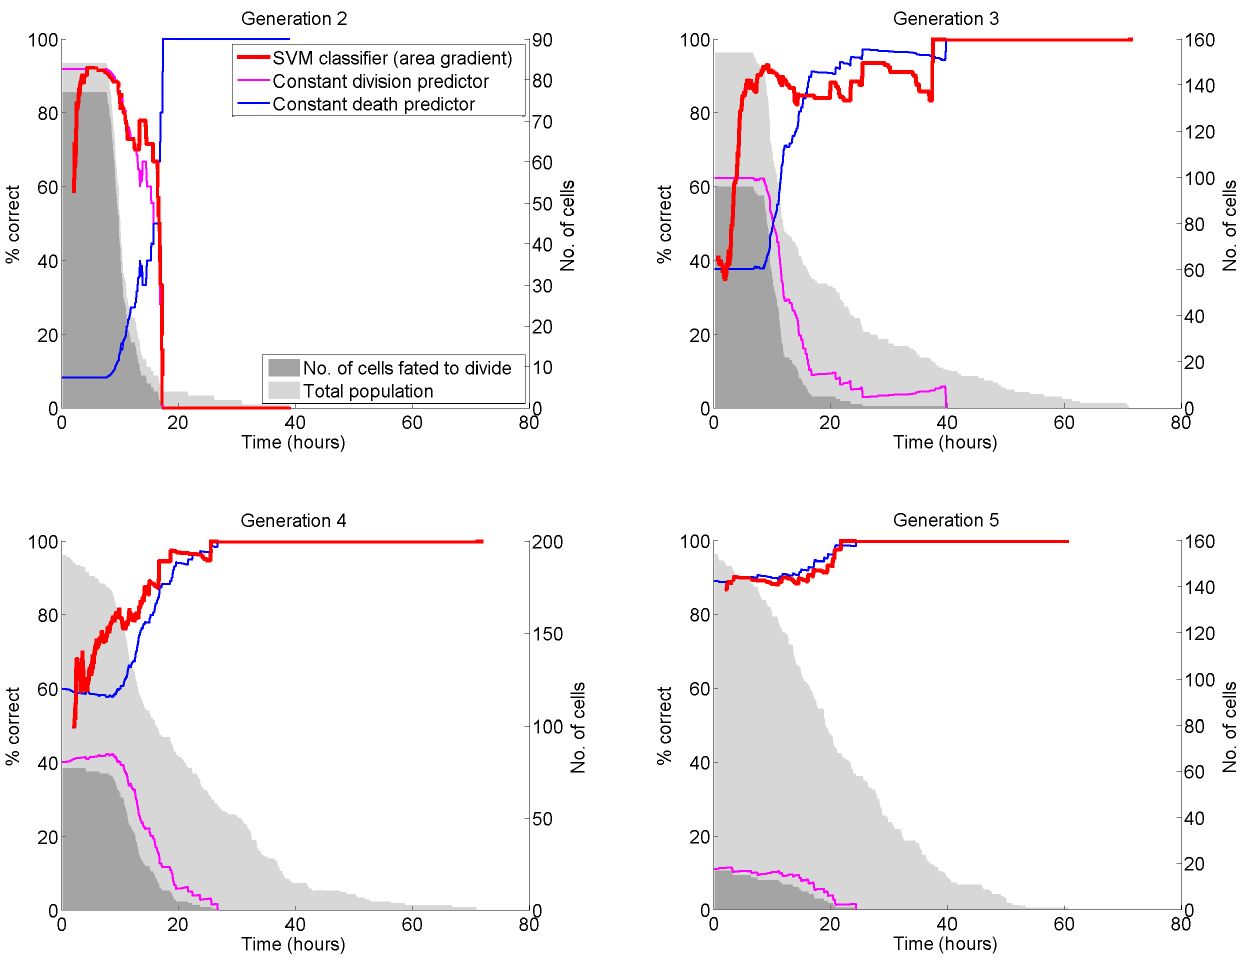
Figure 3. Predicting the fate of tracked cells by measuring growth. We used a simple SVM classifier to predict the fates of lymphocytes given the gradient of their observed area over time. Gradients were calculated from a rolling window of area measurements. In some generations we were able to predict cell fate with more than 90% accuracy shortly prior to the majority of divisions and before almost all deaths. The fate of every cell was independently predicted (series shown in red) at the time of capture of every image given data about its observed area produced by tracking. Since in many generations or after most division events the majority of cells have the same fate, we also show the prediction accuracy possible by predicting all cells die (blue series) or divide (pink series). We expect the SVM predictor to perform better than either constant-fate prediction. To be useful, the classifier must correctly predict fates before they occur. A period of observation is required to measure growth accurately, but these results show that for the majority of cells enough measurements are available prior to most division events. In many generations (including those not shown) there was insufficient training data, or the samples were highly skewed to a specific fate. These factors reduced classifier accuracy; with more data, it is likely that better classification could be achieved. We have included less successful results such as generation 5 to illustrate the effects of highly skewed training data. Since we used only 33% of data for training, the classifier in generation 5 had only 6 training samples for the dividing